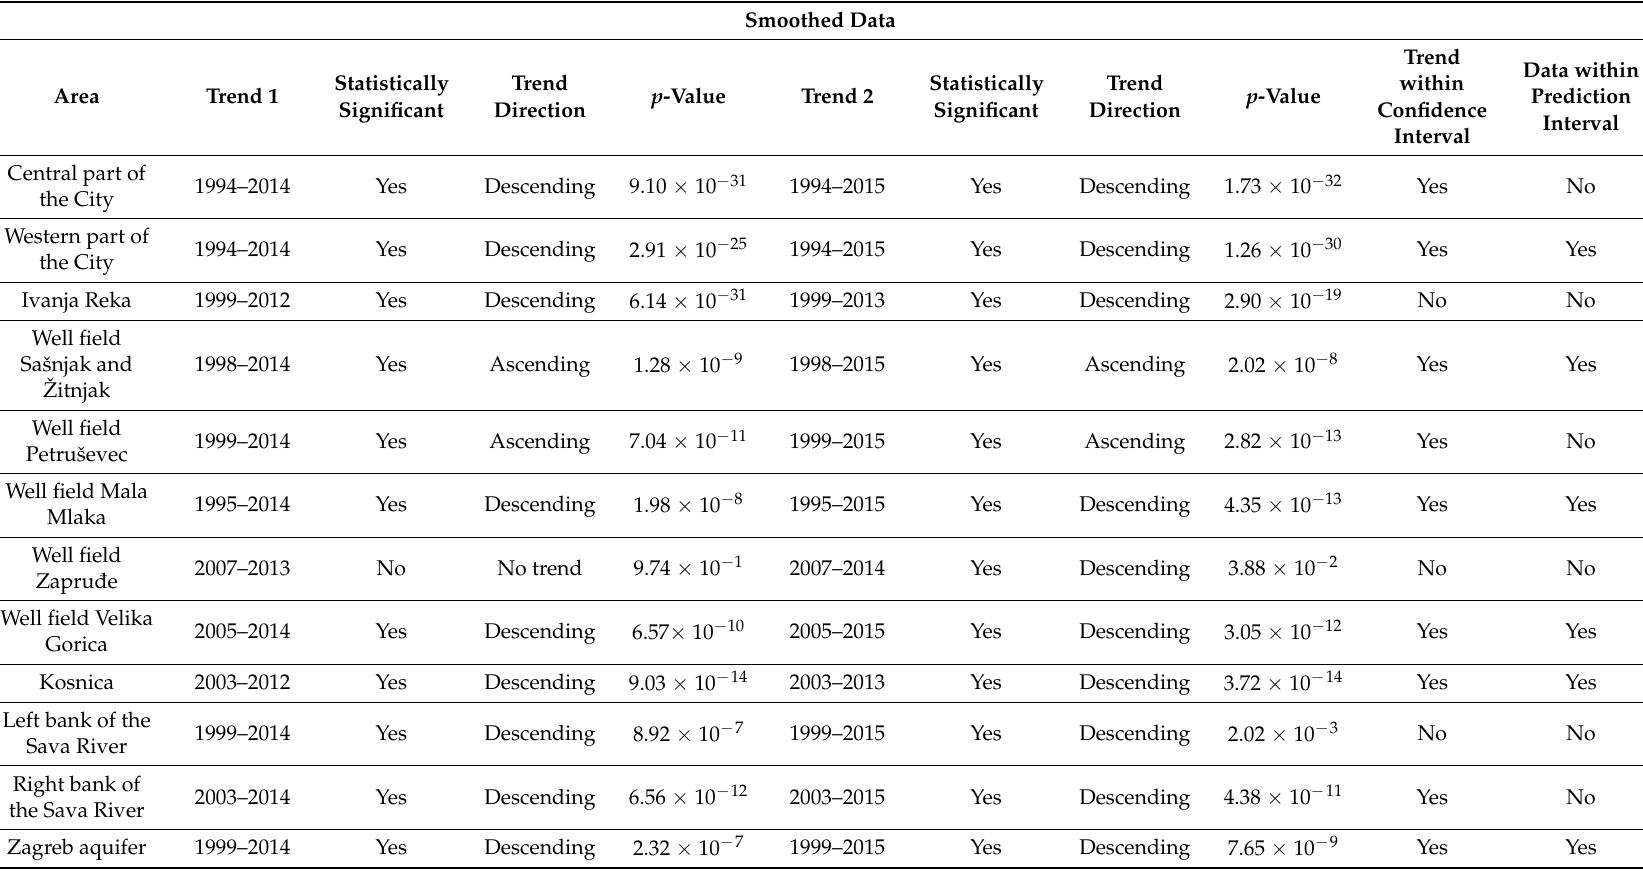
Table 2. Summary results of nitrate trends estimation at different observational scales (smoothed